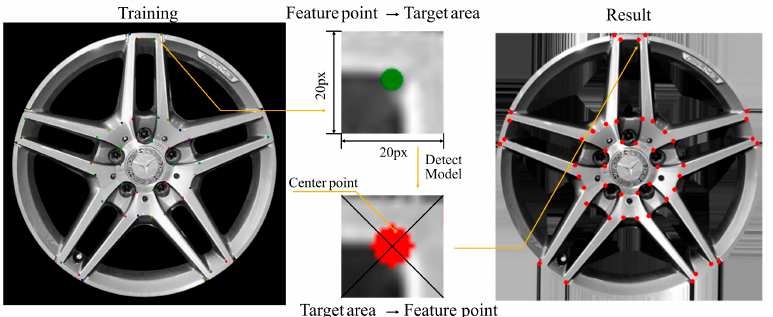
Figure 4. Transformation process of feature points and target areas. Transform the labeled feature points (green circle) into a 20 px × 20 px square target area for the training process; the midpoint of the feature region (red circle) obtained by the detection model result is the extracted feature point.